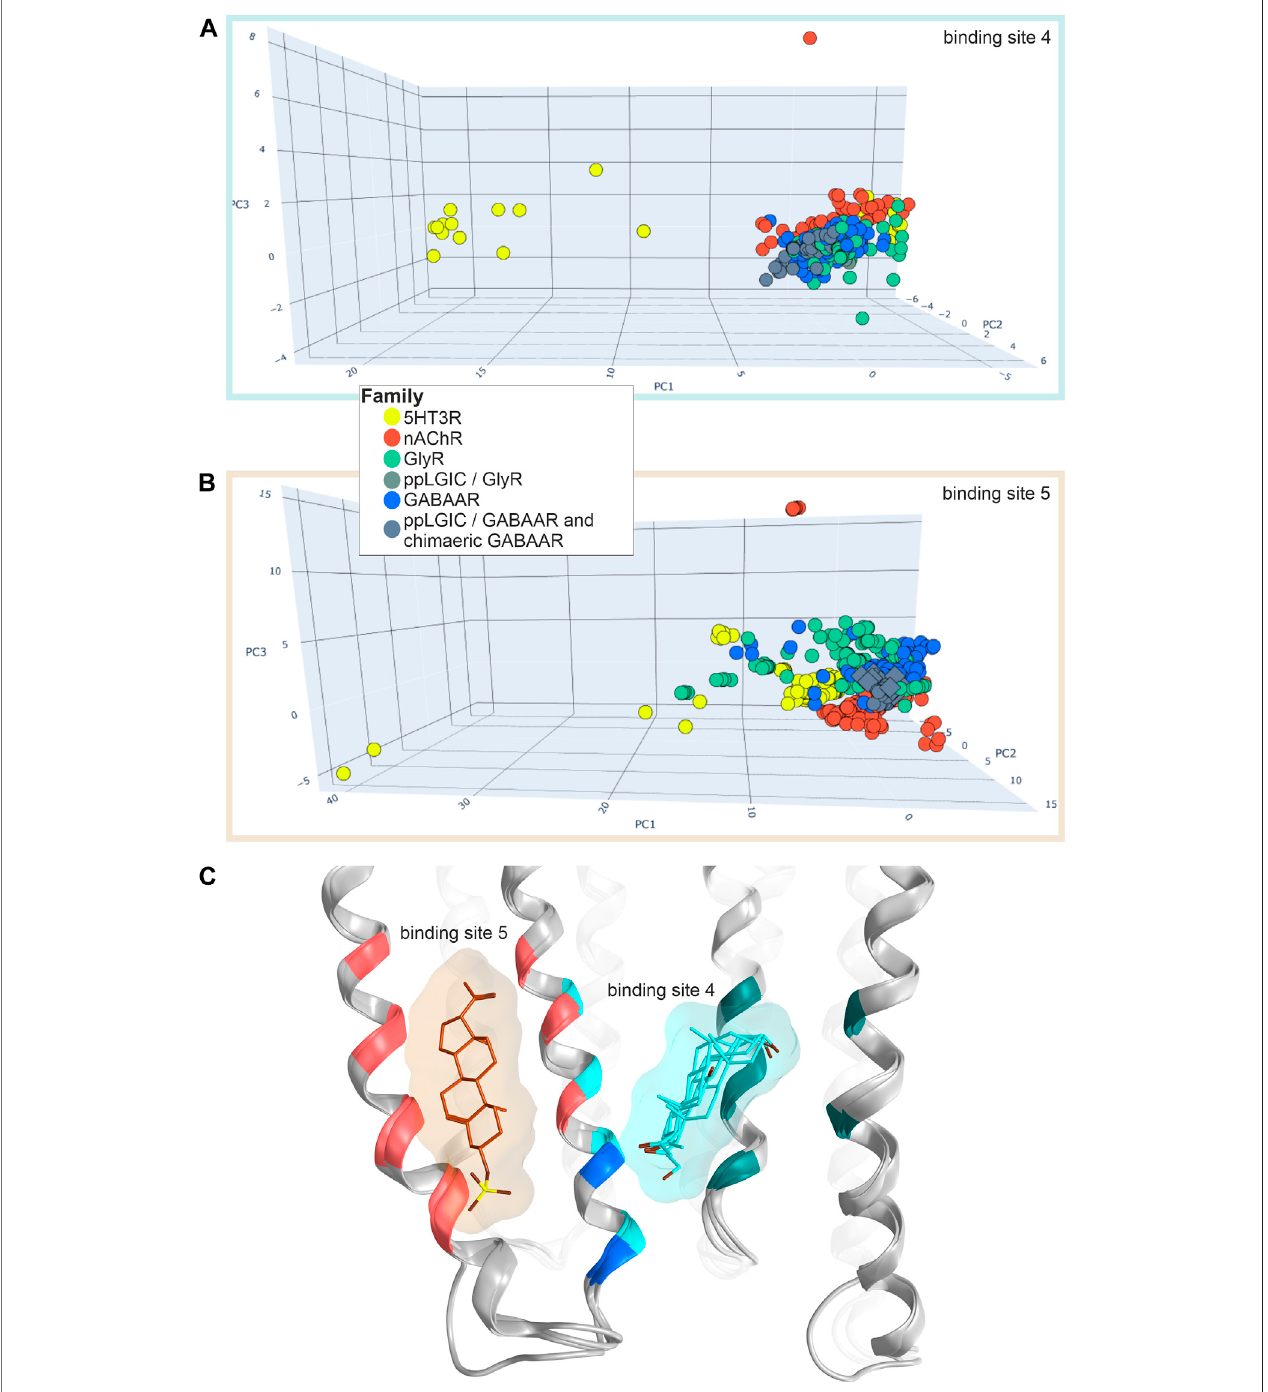
FIGURE 8 | Conformation analysis of the lower TMD with sites 4 and 5: (A,B) Scatter plots of the pocket conformations. Each dot represents the results for an individualsite,diamondshaped symbolsindicatethepresenceofaligandintheanalysedsite.Thecolourofthedotsindicatestheproteinfamilyasde fi ned inthelegend, gray is used for diverse chimeras. ppLGIC: procaryotic pentameric ligand gated ion channel. (C) Superposition and comparison of 5OSB, 5OSC, 5O8F and 6CDU. Pregnenolonesulfateboundtosite5isrenderedinbrownsticks,THDOC,alphaxaloneandpregnenoloneboundatsite4incyansticks.Ribboncolouringindicates contributions to site 5 (red), 4 (cyan) or both